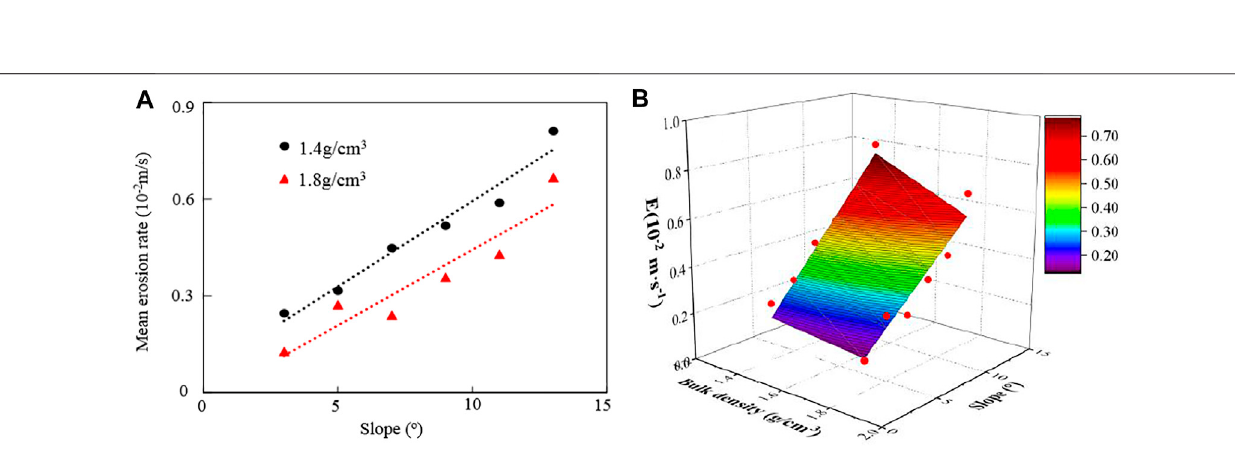
Frontiers in Earth Science |